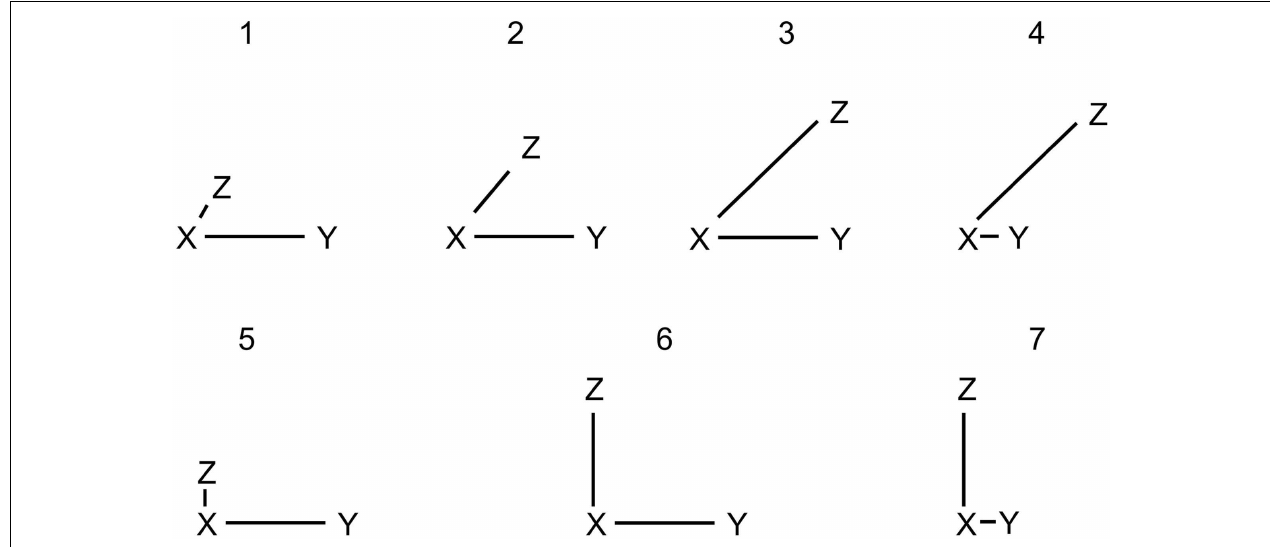
have equal distances and are termed equal-distance models (EDM).The model 3 is termed cardinal model (CM) because the to-be-inferred relation corresponds to one of the main cardinal directions, i.e., north, east, south, or